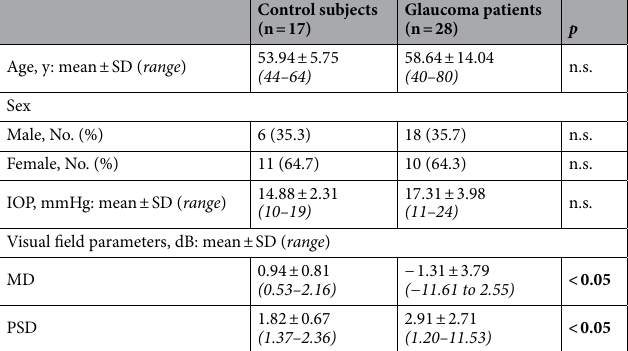
Table 1. Demographical and clinical characteristics of control group and glaucoma group. The IOP values reported for the patient group are intended as treated-IOP values. The statistical significance ( p -value) of t -test comparisons between group parameters is